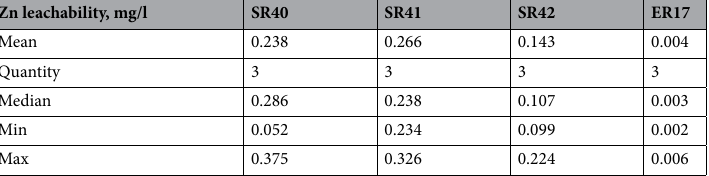
Table 7. Results of leachability tests of Zn from SBR and EPDM rubber granules. SR SBR granulate sample provided by the recycler, ER EPDM granulate sample provided by the recycler.